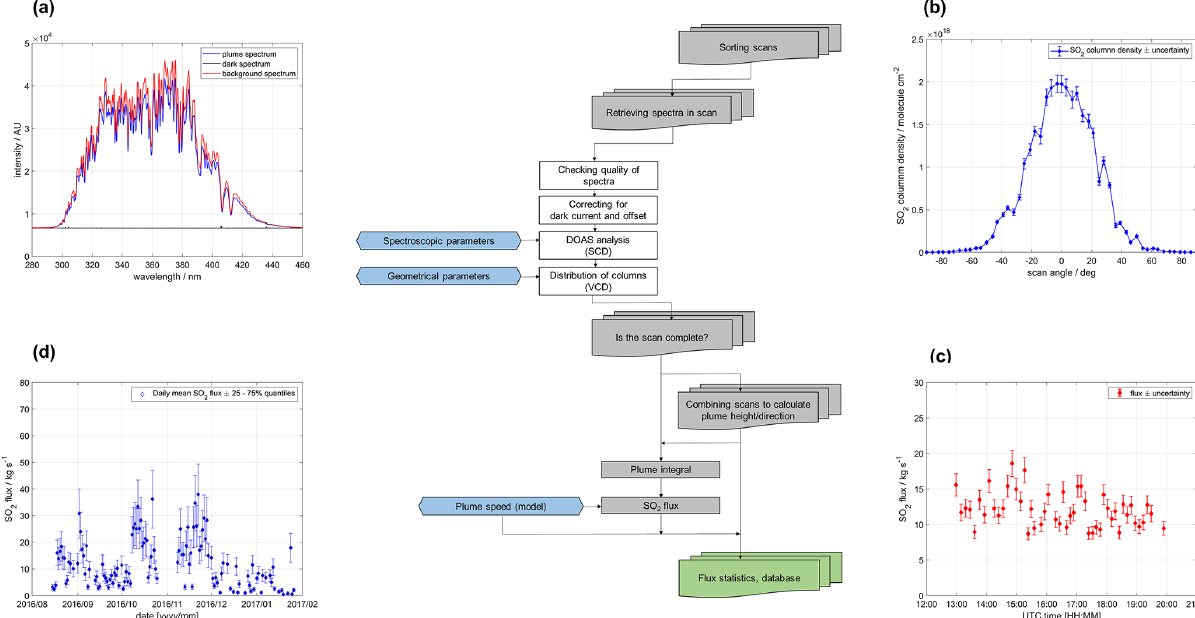
Figure 2. Schematics of the algorithm used to derive time-averaged emission of volcanoes in the NOVAC database. (a) Scattered sunlight spectra (shown in the figure as uncalibrated spectral radiance in arbitrary units; AUs) are checked for quality and combined to correct instrumental effects and to derive the differential slant column density (SCD) of SO 2 through the non-linear DOAS method. (b) A collection of column densities in the scan is used to determine the baseline column density and the angular position of the centre of mass of the plume, to convert the slant to the vertical column density (VCD), and to estimate the completeness of the scanned plume. (c) Pairs of scans taken close in time by different instruments are used to derive plume altitude and direction. This is combined with plume speed using a meteorological model to derive the flux, including uncertainty. Individual flux measurements are chosen considering uncertainty, completeness, and other criteria. (d) If at least five valid measurements exist on a given day, statistics of daily emission are computed and reported in the NOVAC database. The background colour of the boxes indicates processing at the spectral level (white), scan level (grey), flux level (green), and external parameters